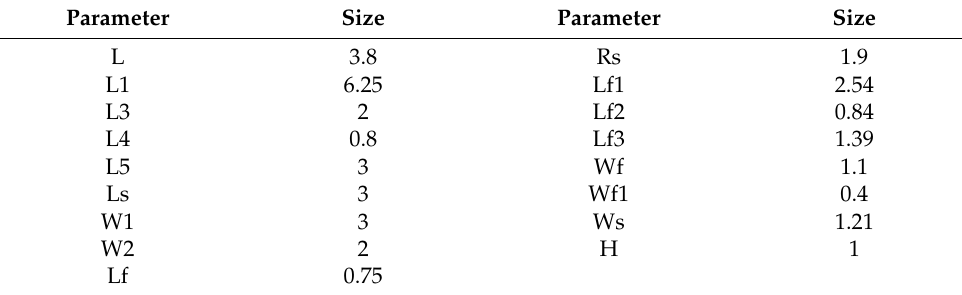
Figure 3. Detailed antenna structure: ( a ) side view; ( b ) top view; ( c ) isolation ground; and ( d ) bottom view. Table 1. Dimensions for the Proposed Antenna (unit: mm).